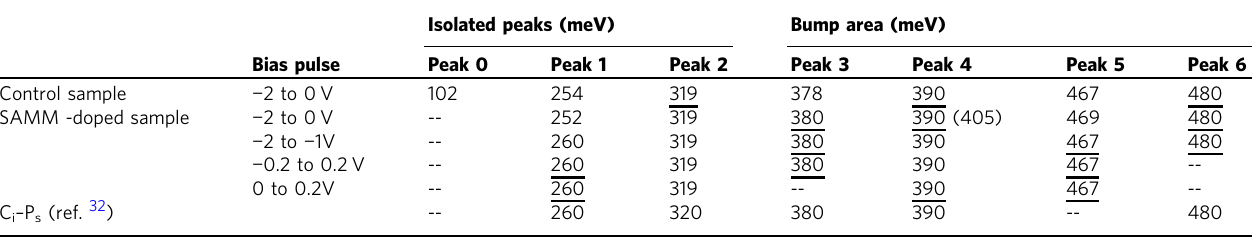
Table 2 Comparison of the energy levels derived from DLTS spectra, simulations and energy levels of C i – P s from ref.